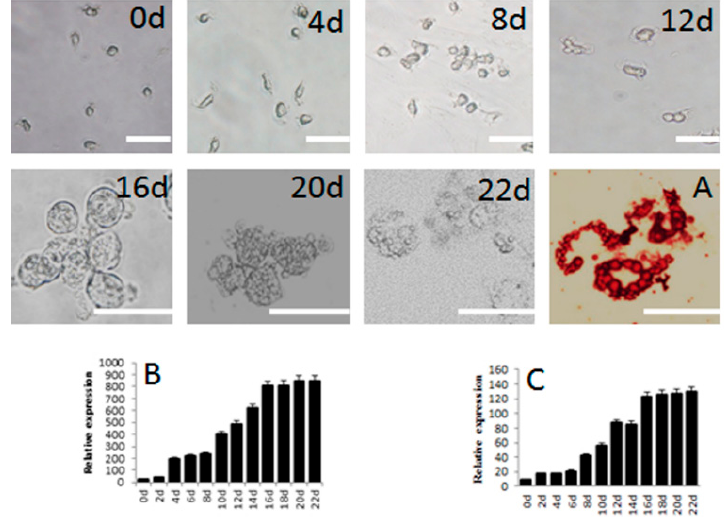
Figure 6. Morphology and gene expression of SSCs differentiated into adipocytes in vitro . Appearance under the microscope and various staining properties were used to confirm their identity. Schematic represents the strategy used for in vitro differentiation. 0d, 2d, 4d, 6d, 8d, 10d, 12d, 14d, 16d, 18d, 20d, 22d mean the same, 2th, 4th, 6th, 8th, 10th, 12th, 14th, 16th, 18th, 20th, 22th day after induction. ( A ) Oil red-O staining of adipocytes derived from SSCs; ( B ) Expression of PPAR γ and ( C ) C/EBP α , both measured by mRNA levels, during induction. Scale bar: 5 µ